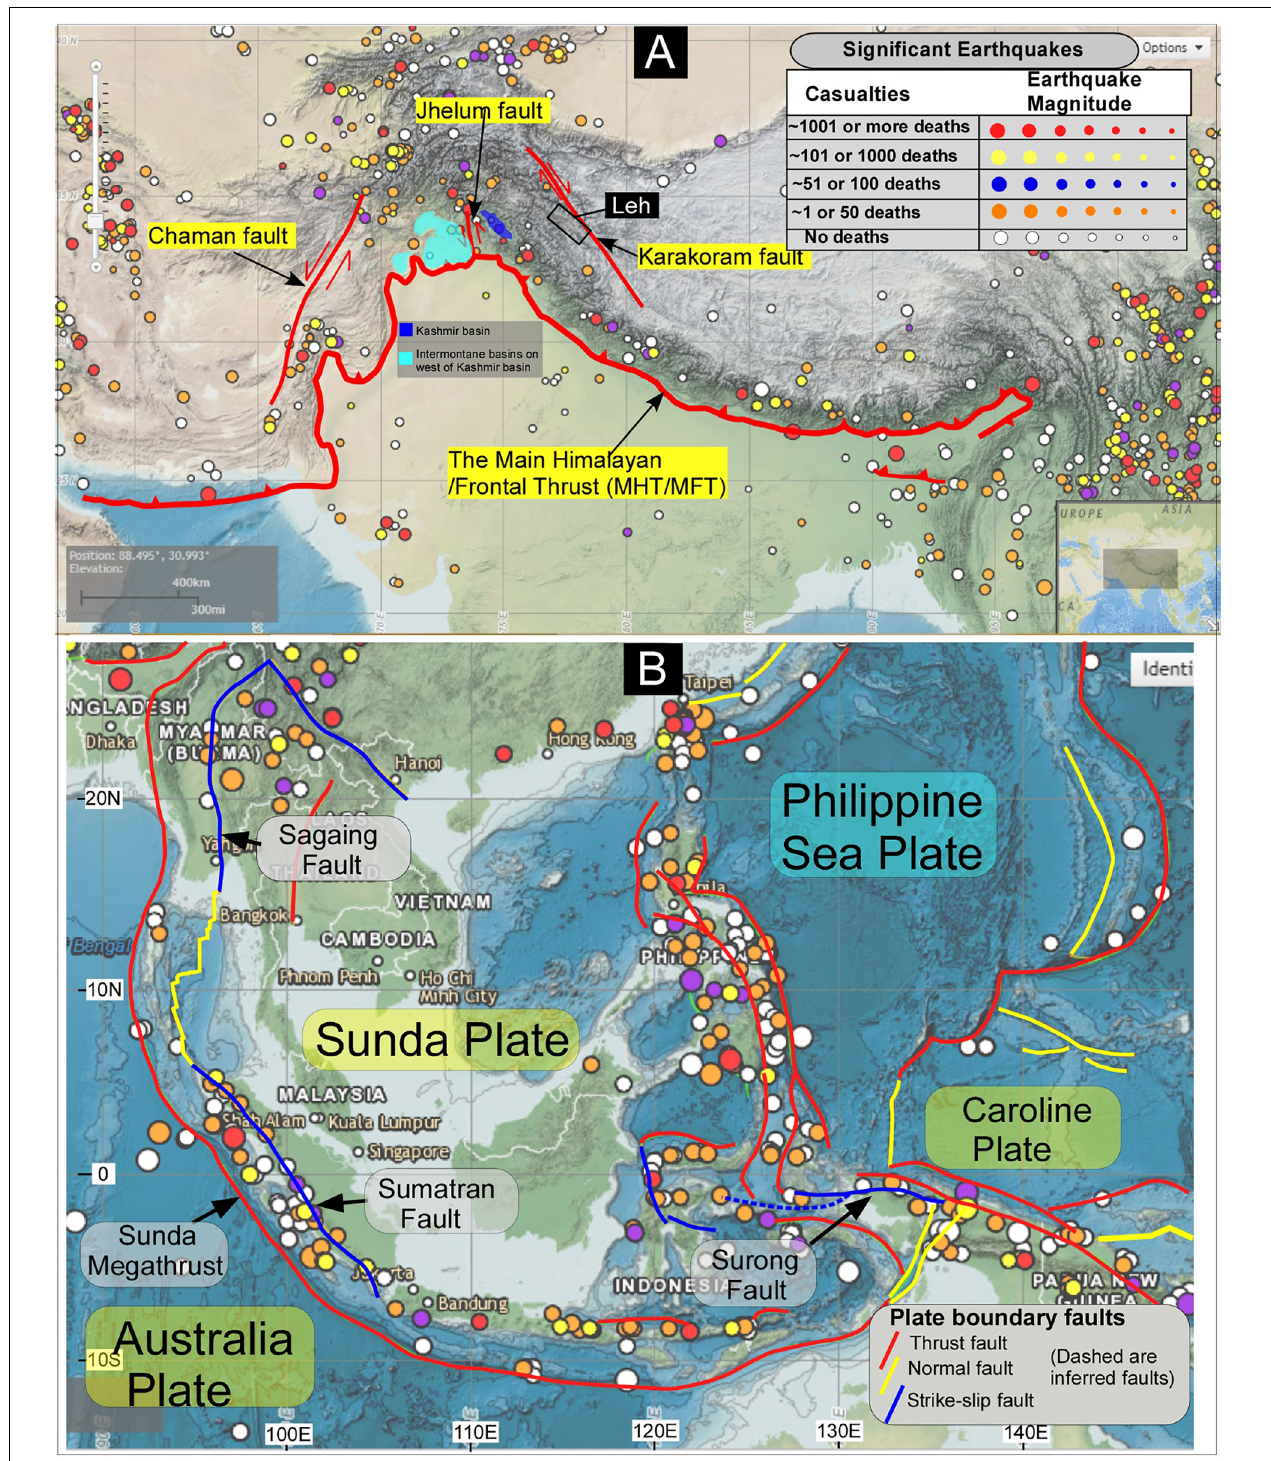
FIGURE 2 | (A) The topographic map shows some of the major faults in South (after Shah et al., 2018a) and Southeast Asia (B) . The colored dots are significant earthquakes (Mw 6 and above with a depth of 0–50 km) in the region, which dates back to 2150 B.C. until present. The earthquake and plate boundary data (some boundaries are modified) are obtained from the National Geophysical Data Center/World Data Service (NGDC/WDS): Significant Earthquake Database. National Geophysical Data Center, NOAA. doi: 10.7289/V5TD9V7K.